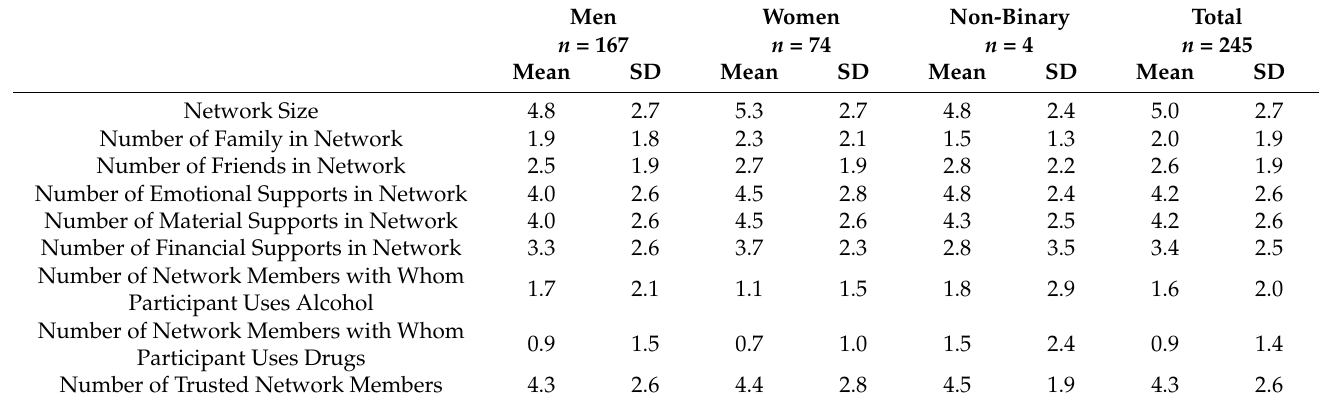
Table 4. Social network characteristics of n = 245 unsheltered PEH in Nashville,